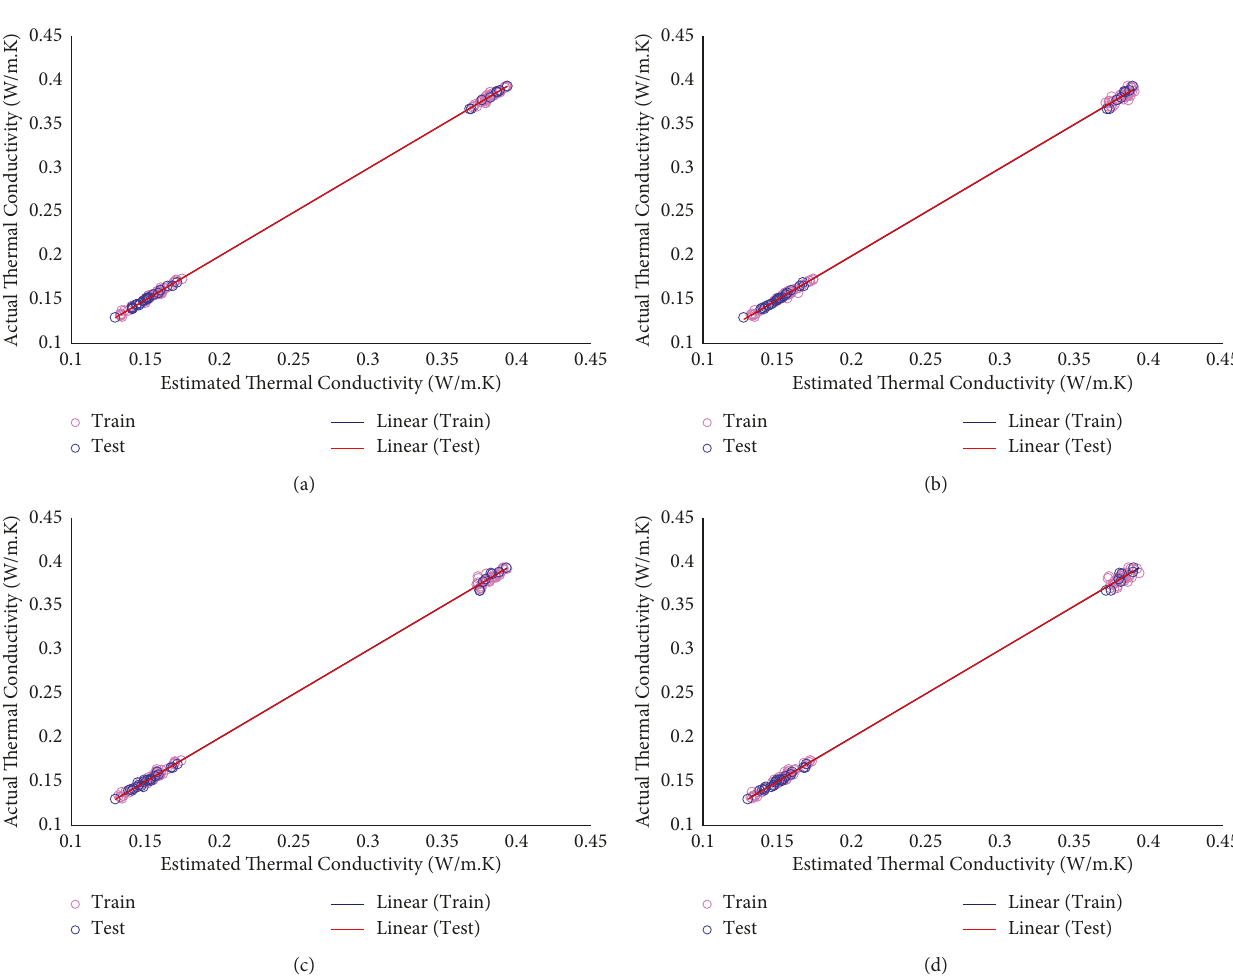
Figure 4: Cross plot analysis to determine the accuracy of different models in predicting target values using various KFs: (a) M, (b) E, (c) SE, and (d)